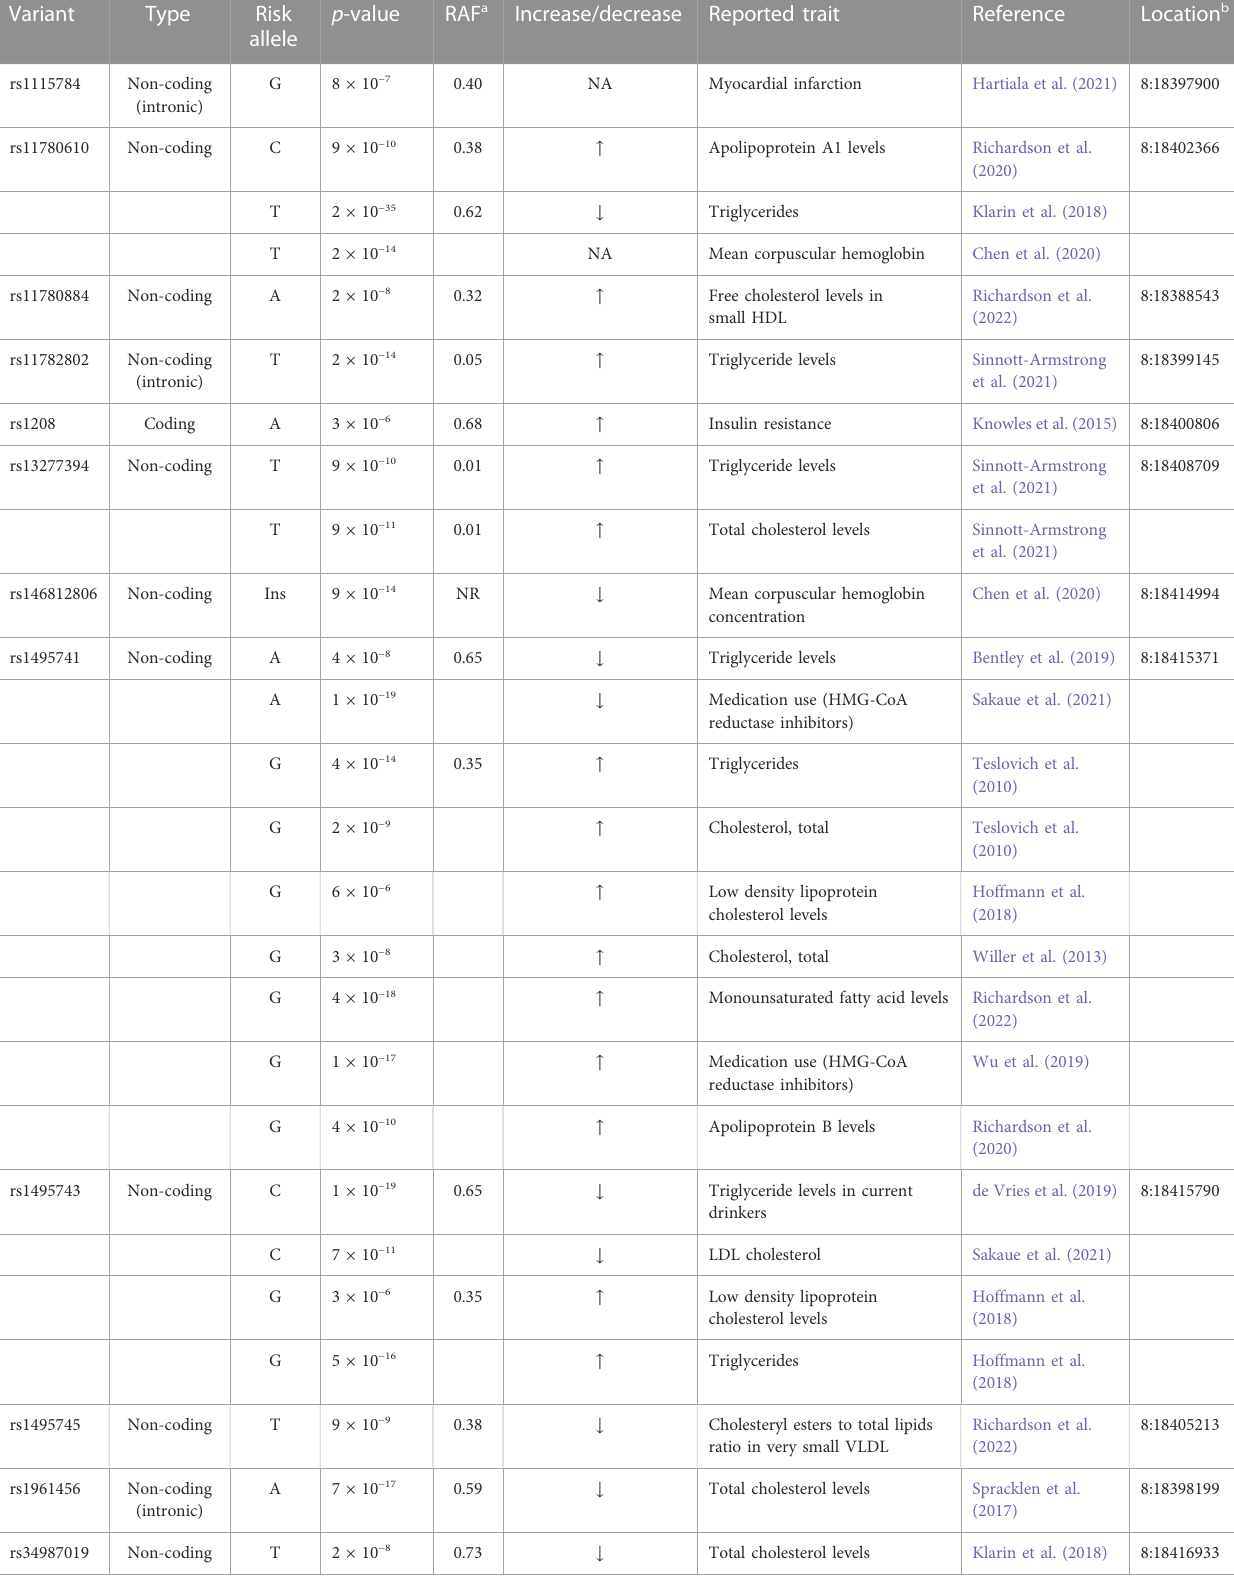
TABLE 1 NAT2 genetic variants associated with differential plasma lipid, cholesterol, or fatty acid